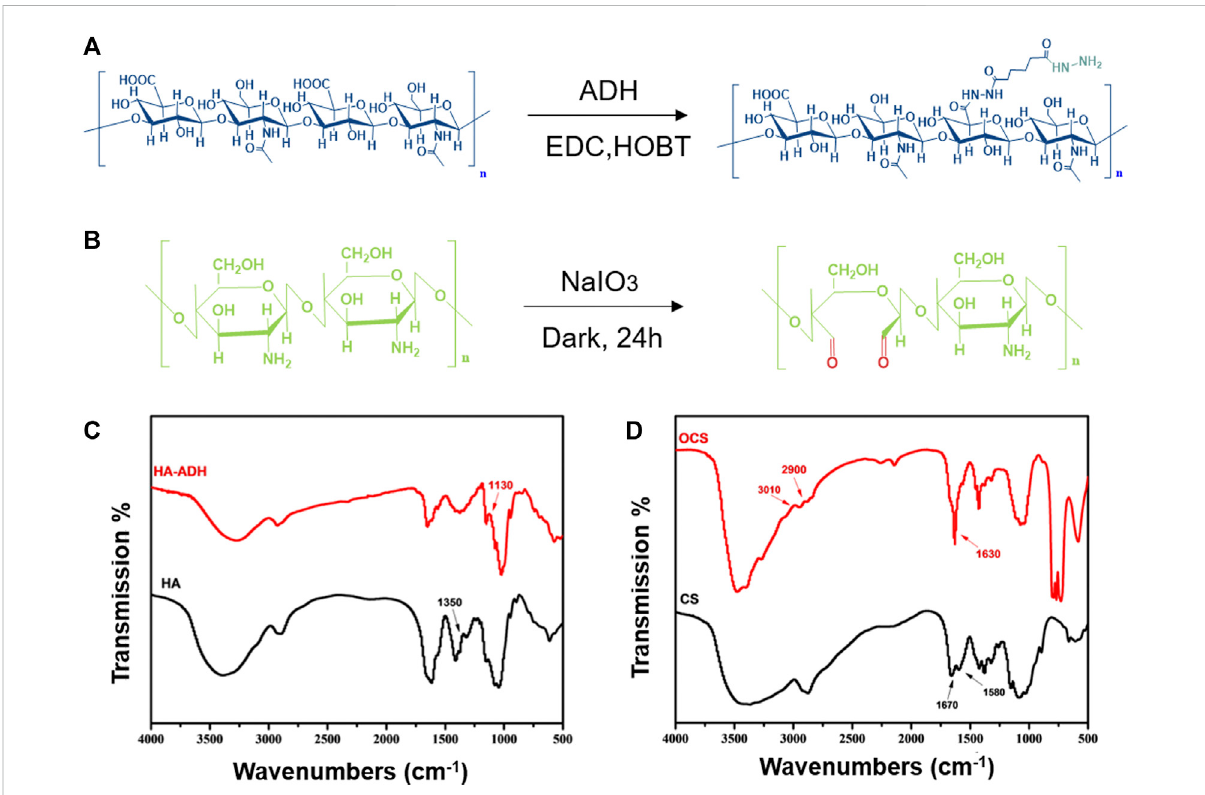
FIGURE 2 Fabrication and structural characterization of HA-ADH and OCS. The synthetic route of (A) HA-ADH and (B) OCS. FT-IR spectra of (C) HA, HA- ADH, (D) CS, and OCS.